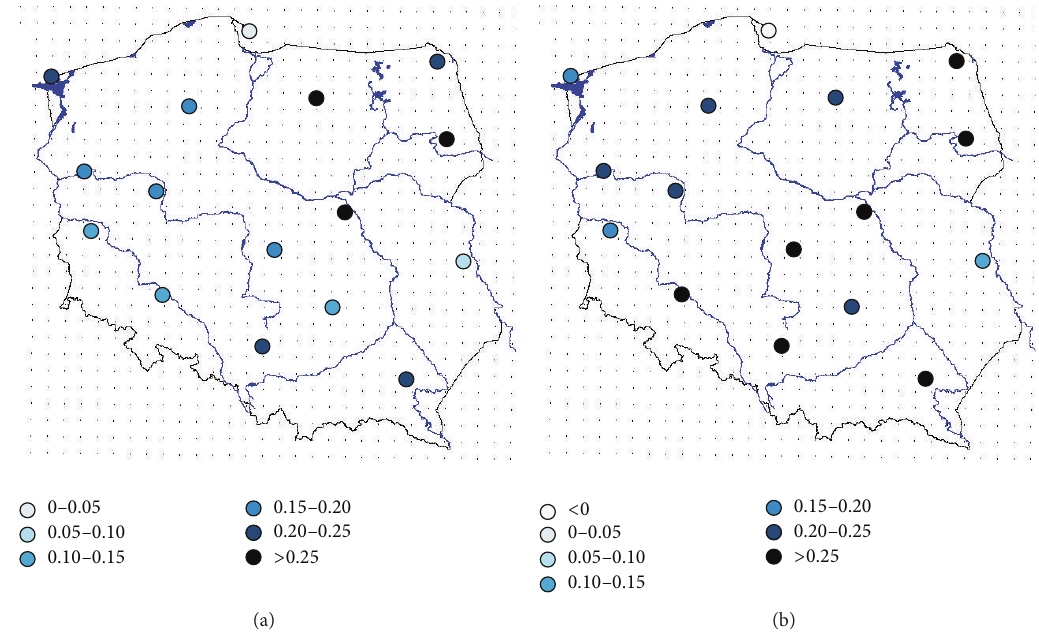
Figure 9: The annual runoff coefficient for the future 2061–2090: (a) based on MPI-M-REMO model and (b) an average value from five